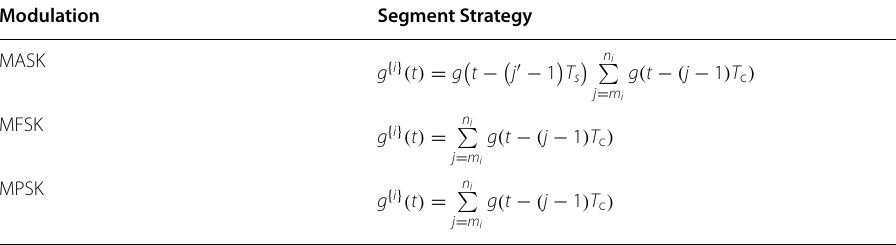
Table 4 Representation of modulated signals Modulation Segment Strategy